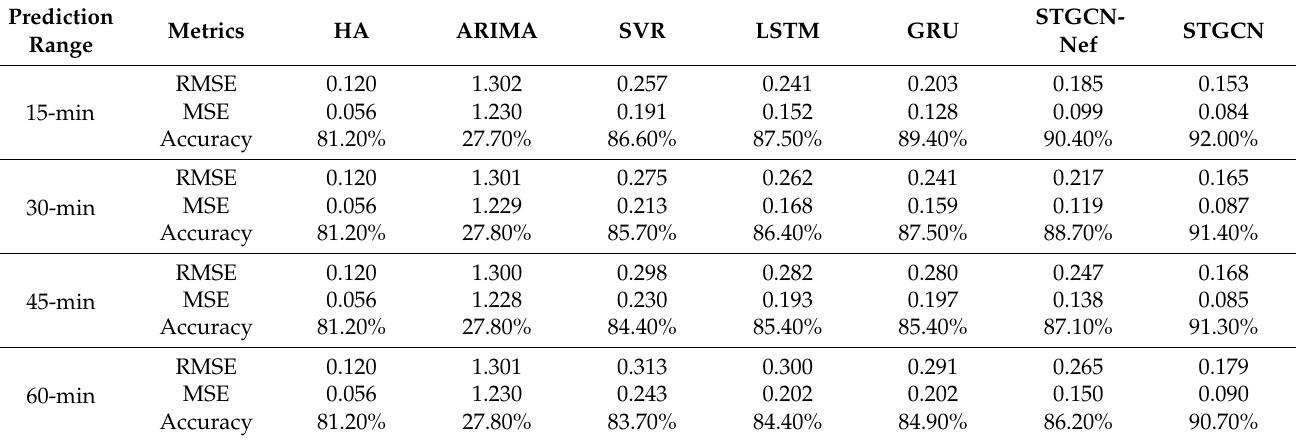
Table 3. Comparing the regression prediction performance of different models on the dataset of air traffic situation in 30 Shanghai control